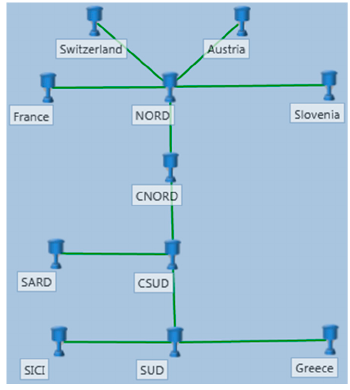
Figure 3. Network configuration.